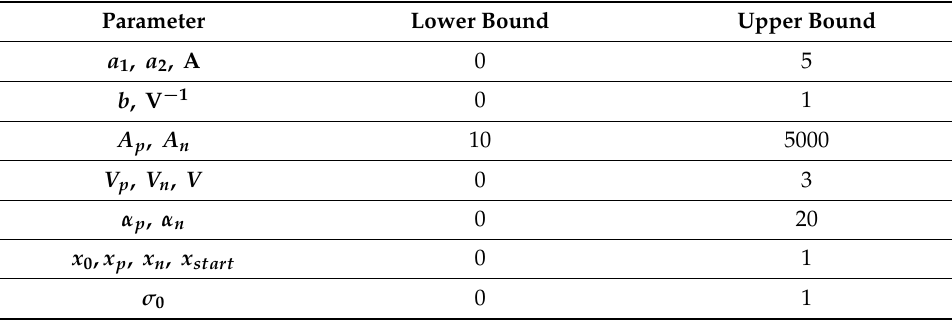
Table 2. Chosen ranges of the model parameters in training set.